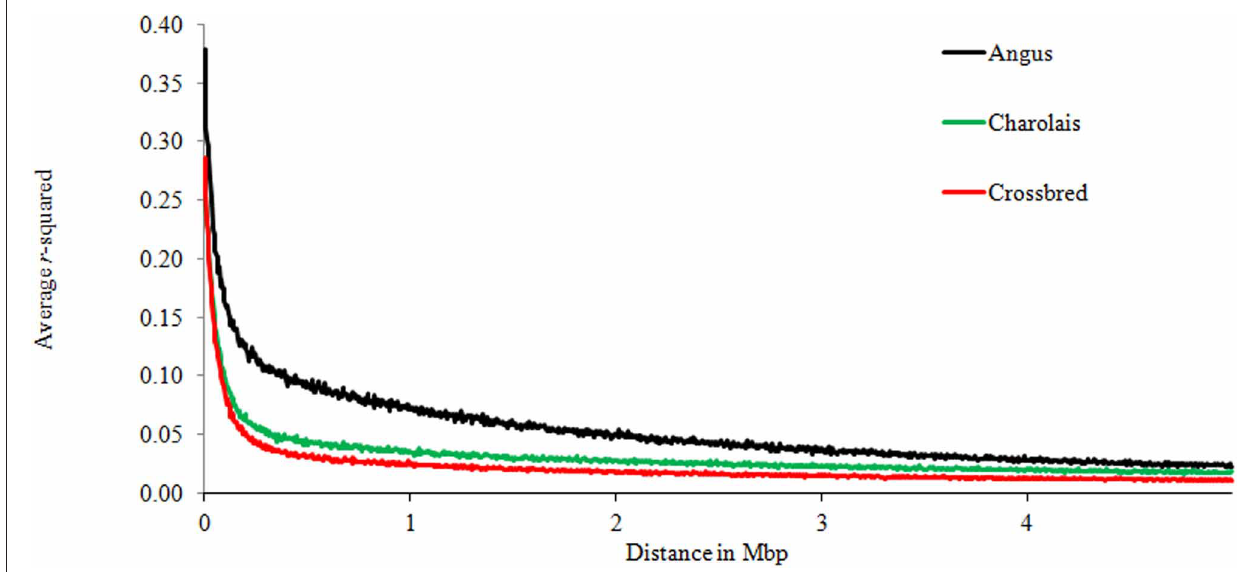
FIGURE 2 | Average LD over genomic distance for Angus, Charolais, and Crossbred.